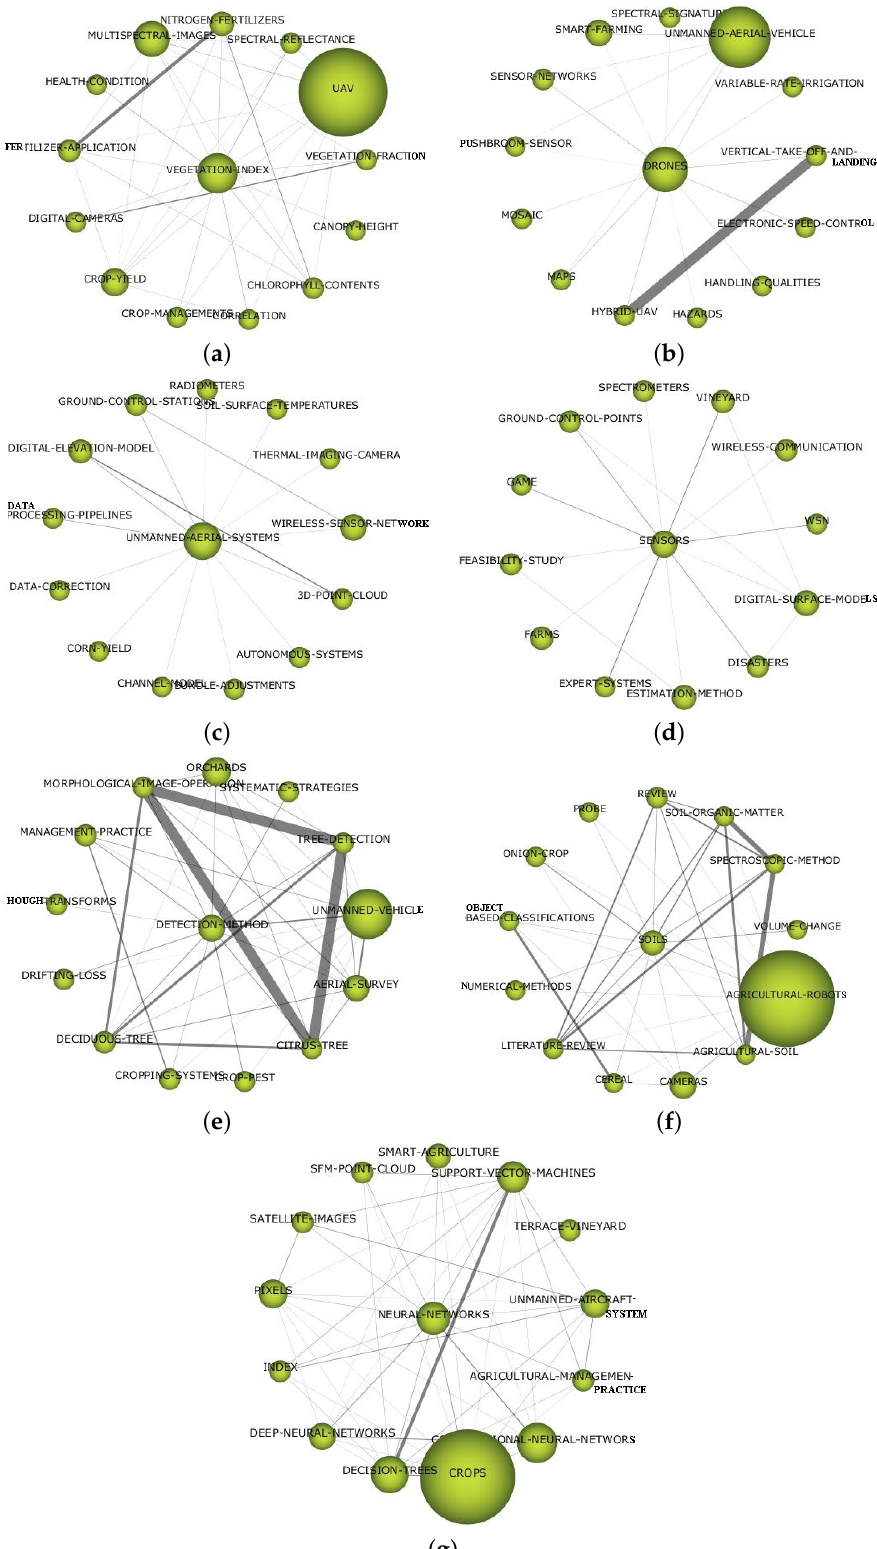
Figure 4. Thematic network structures. The size of the clusters is proportional to the h-index of the associated documents and the significance of the theme in the research field, while the thickness of the lines indicates the strength of the relationship between the clusters. ( a ) Vegetation index; ( b ) drones; ( c ) UAS; ( d ) sensors; ( e ) detection method; ( f ) soil; ( g ) neural